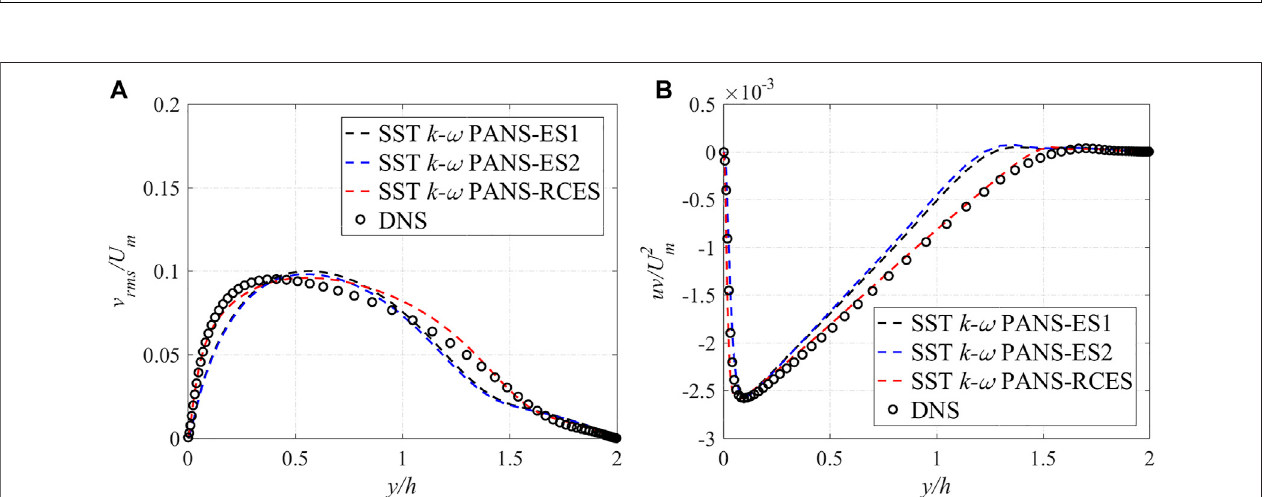
FIGURE 8 | Comparison of turbulence statistics at Ro =0.6 (A) normal RMS velocity (B) Reynolds shear stress.